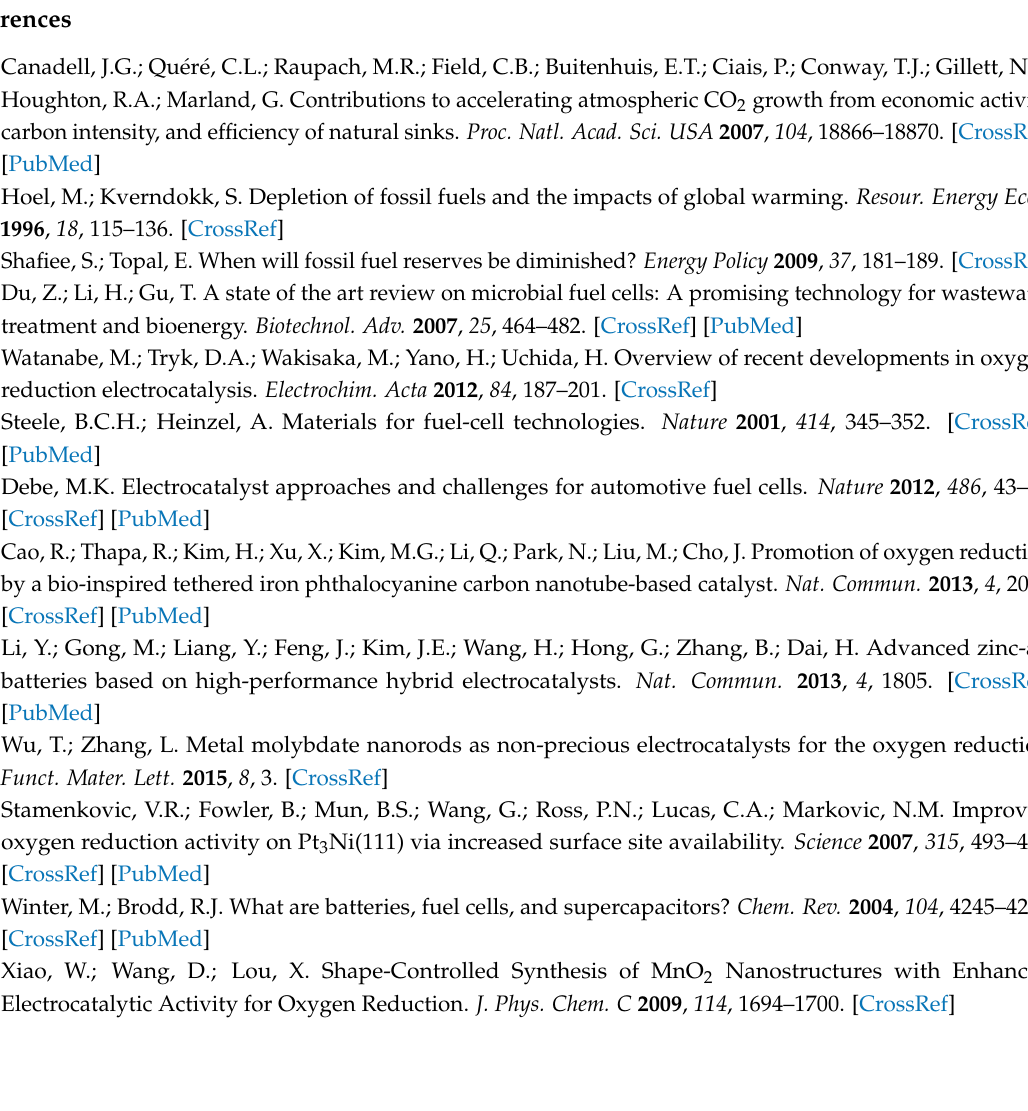
Figure S1. Raman spectra of graphene oxide, Table S1. Comparison of ORR activity parameters with other recently reported. 1. Physical characterization, 2. Electrochemical